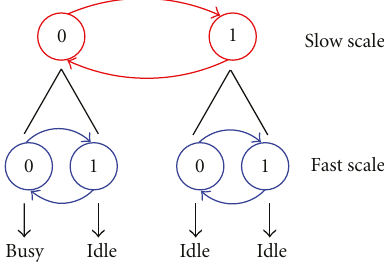
Figure 1: A multiple time-scale hierarchical Markovian model for self-similar primary tra ffi